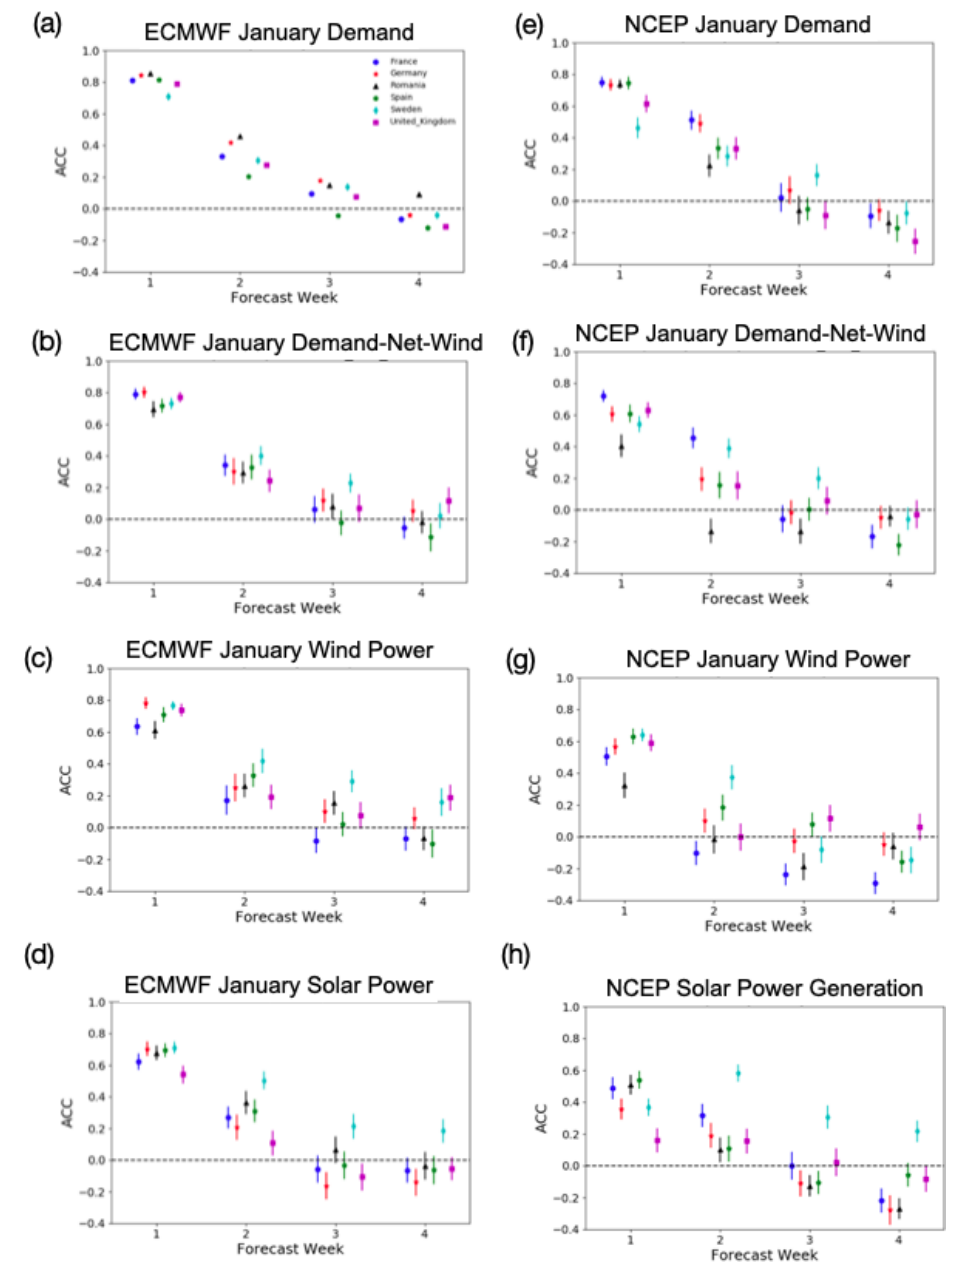
Figure 2. Forecasts of weekly-mean January energy variables for the ECMWF (a–d) and NCEP (e–h) models. Definitions of the lead weeks are given in Sect. 2. Error bars show the 95% significance. Colours show a set of representative case study countries: France, Germany, Romania, Spain, Sweden and the United